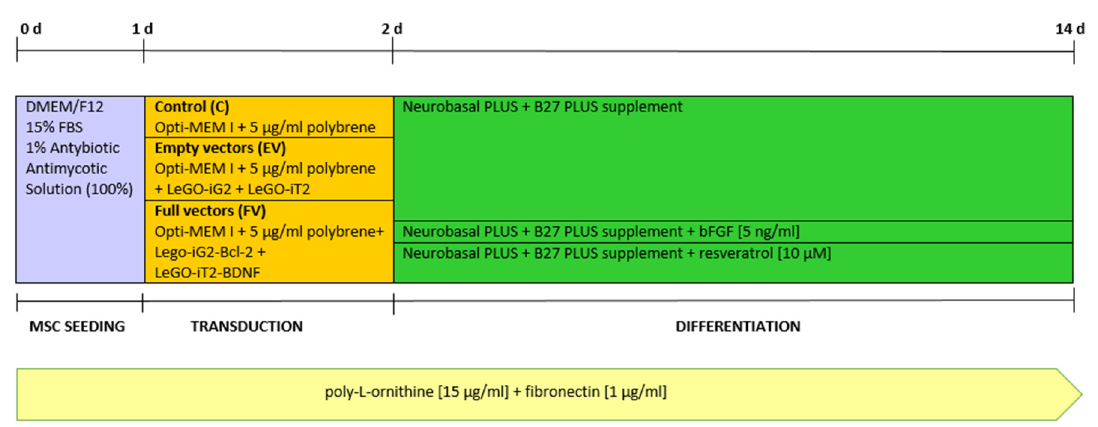
Figure 5. Overview of the methods for seeding, transducing, and differentiation.